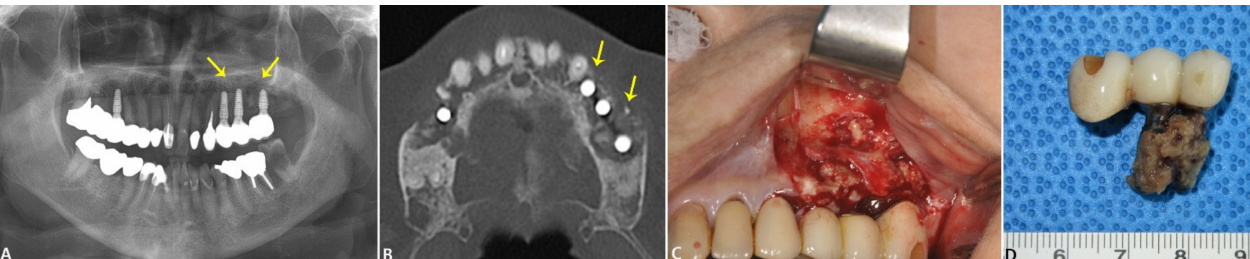
Figure 2. Preoperative radiographic examination of case 2. The panoramic radiograph shows generalized alveolar bone loss and calculi deposition, apical involvement of the #36 tooth; furcation involvement of the #37 tooth; peri-implant bone loss around the #15, #24, #25, and #26 teeth; and left maxillary sinus opacification (marked with arrows) ( A ). CT imaging showed bone fracture and sequestrum formation in the right and left sides of the maxilla and left mandible. Cortex destruction, sequestrum, calculated marrow attachment, and adjacent bone sclerosis were observed in the areas of #11 to #17, #24 to #27 (marked with arrows), and #36 and #37 teeth, and the upper and lower cortices were overserved, thus lost in the area of maxillary bone destruction in the axial view ( B ). Intraoperative view of the partial maxillectomy (#25i, #26i, and #27i alveolotomy) surgical procedure. Necrotic bony exposure was observed on the buccal side of the left maxilla ( C ). The extracted #25i, #26i, and #27i implants with necrotic bone attachment ( D